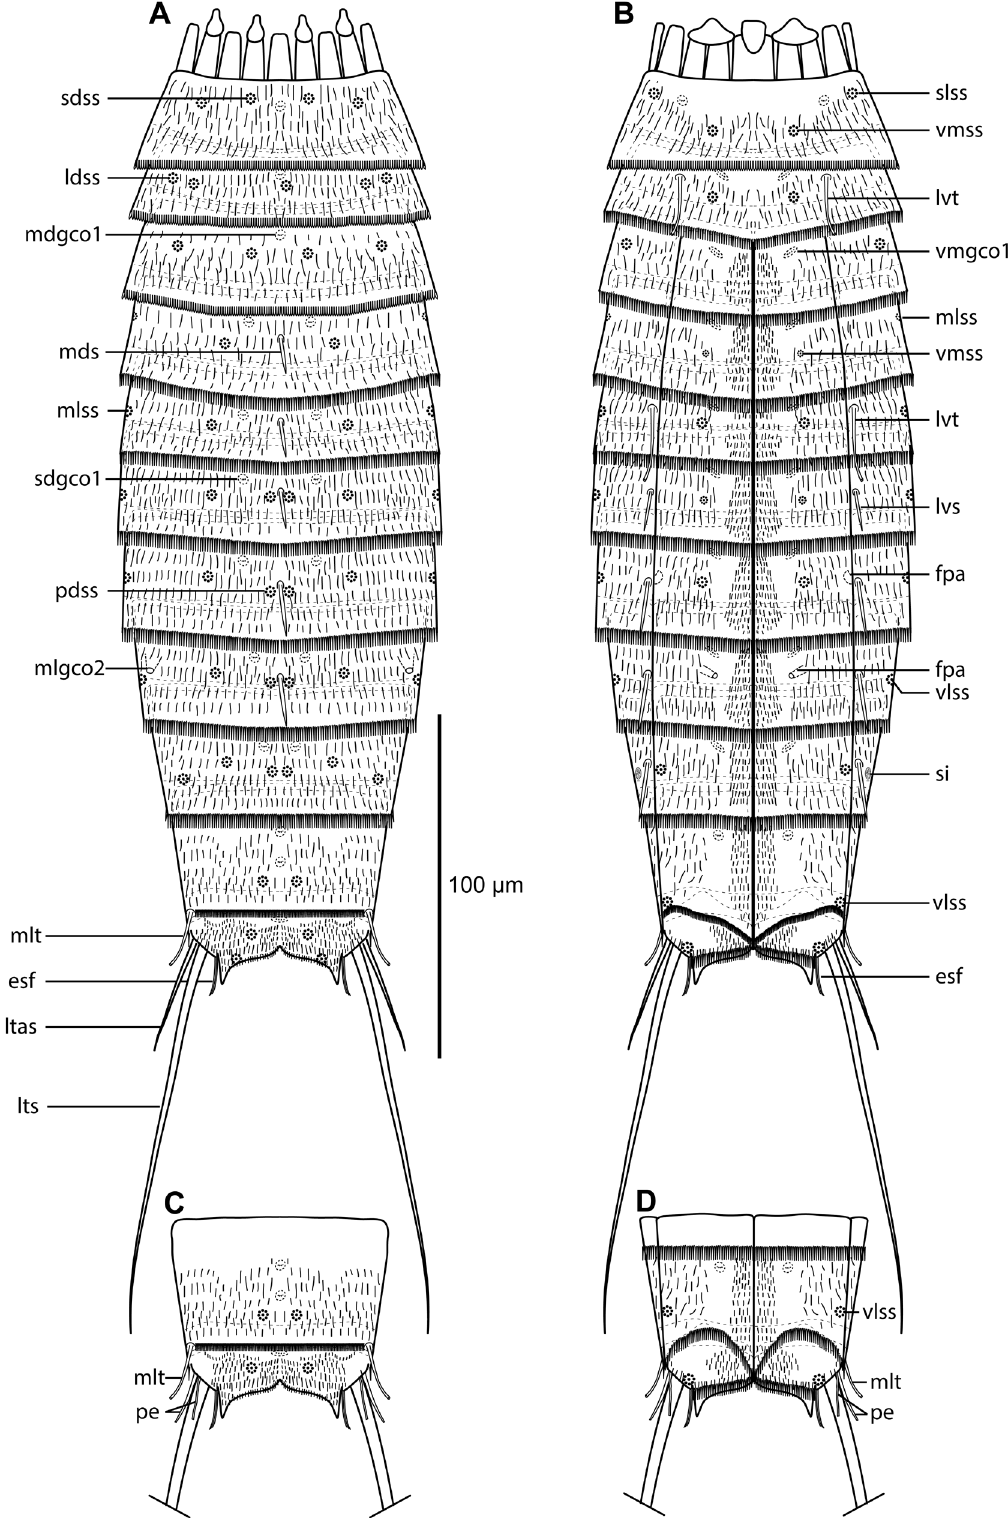
Fig. 19. Line art illustrations of Echinoderes songae Sørensen & Chang sp. nov . A . Female, dorsal view. B . Female, ventral view. C . Segments 10 to 11 in male, dorsal view. D . Segments 10 to 11 in male, ventral